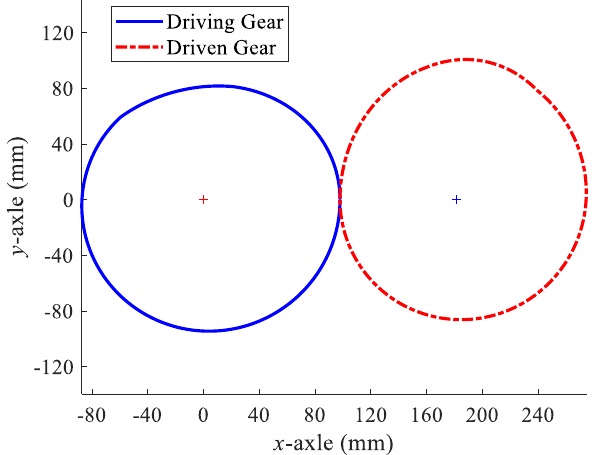
Figure 5. Pitch curves of the conjugate pair.